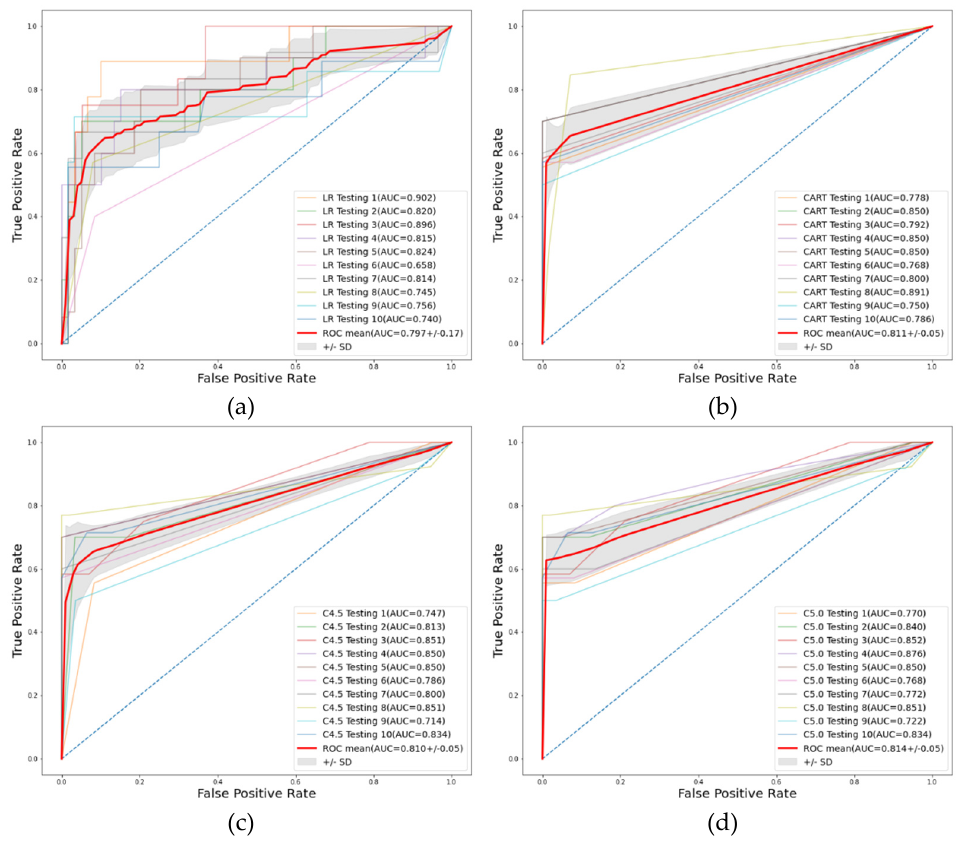
Figure 4. ROC curves of the four decision tree algorithms: ( a ) LR; ( b ) CART; ( c ) C4.5; ( d ) C5.0. As C5.0 has the best AUC and outperforms the four competing methods, the impor- tant clinical factors and decision rules generated and suggested by the best C5.0 model are discussed. Table 3. Summary of the values of the hyperparameters for the best CART, C4.5, and C5.0 models.